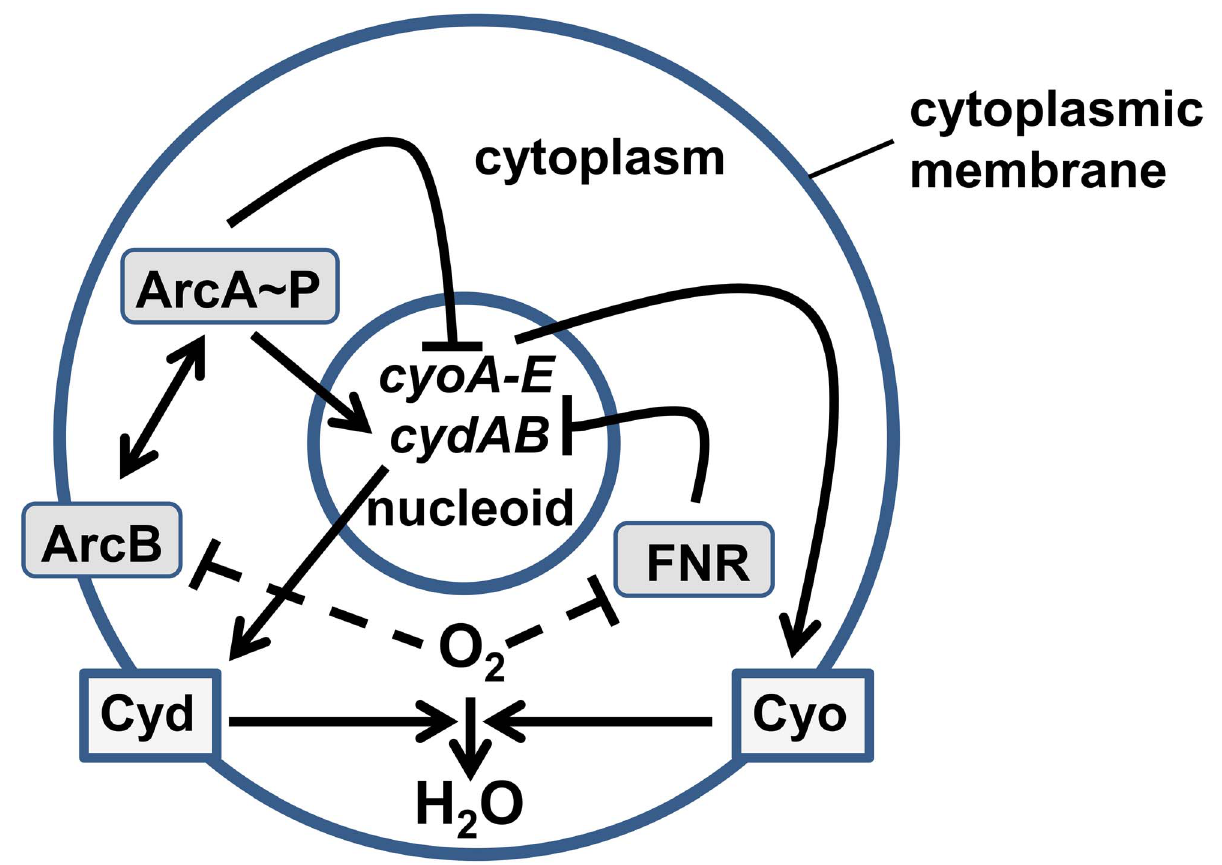
Figure 1. Components of the agent-based model. The diagram shows the interactions between and locations of the components of the model. Oxygen molecules (O 2 ) cross the cytoplasmic membrane and enter the bacterial cell where they are reduced to water (H 2 O) by the action of the membrane-bound terminal oxidases (Cyo and Cyd). The transcription regulator, FNR is located in the cytoplasm and is inactivated by reaction with O 2 . The active form of FNR represses the expression of both the cydAB and cyoABCDE operons located in the nucleoid. The ArcBA two-component system responds to O 2 indirectly (dashed line). The availability of O 2 alters the redox state of the electron transport chain and the production of fermentation products. These changes are sensed by the membrane-bound sensor ArcB, which autophosphorylates when O 2 is restricted. ArcB transfers phosphate to the cytoplasmic regulator ArcA, which acts to repress expression of cyoABCDE and activate expression of cydAB